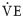
Bland-Altman plots showing differences between two identical K5-units (COSMED, Rome, Italy).Both units operated simultaneously either in breath-by-breath (BBB, left part A) or dynamic mixing chamber (DMC, right part B) mode. Y-axis is 100×(K5A−K5B)÷(K5A+K5B/2). The corresponding mean of both units is shown on the X-axis. Solid and broken lines indicate mean difference and 95% limits of agreement or, in case of magnitude dependent differences, linear regression analysis and 95% prediction intervals, respectively. V˙E = minute ventilation (BTPS), V˙CO2 = carbon dioxide production (STPD), V˙O2 = oxygen uptake (STPD), RER = respiratory exchange ratio (STPD).